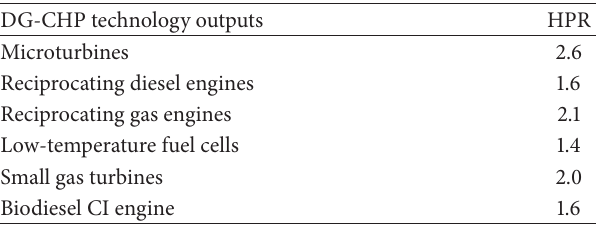
Table 2: Heat-to-power ratio (HPR)